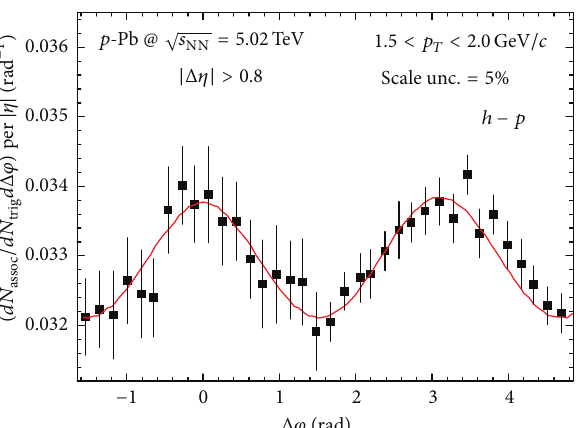
Figure 3: Δ𝜑 dependence of the associated yield per trigger particle for ℎ − 𝑝 correlations for 1 . 5 < 𝑝 𝑇 < 2 . 0 GeV/ c for the event class = 5 . 02 TeV. The |Δ𝜂| range is averaged over 0 . 8 < |Δ𝜂| < 1 . 6 on the near side and |Δ𝜂| < 1 . 6 (0–20%)–(60–100%) in p -Pb collisions at √𝑠 NN on the away side. Systematic uncertainty is less than 5%. The symbols denote the data of the ALICE Collaboration at the LHC [14], and the solid line is the modeling result.